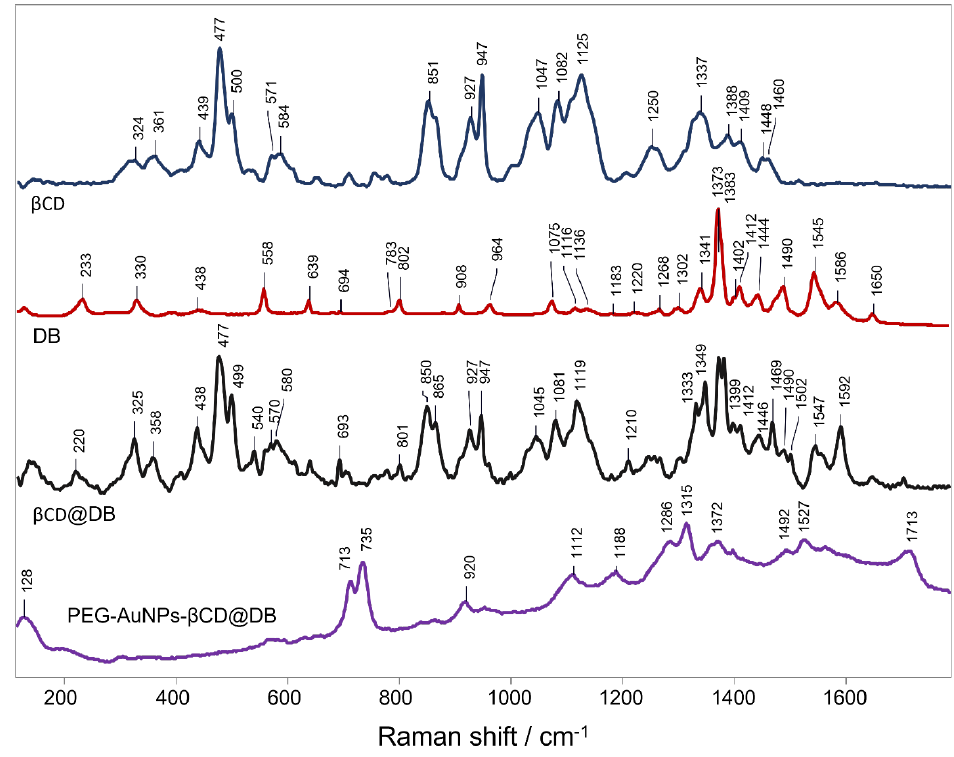
Figure 5. Raman spectra of βCD, DB, and βCD@DB, and SERS spectra of PEG -AuNPs- βCD @DB.